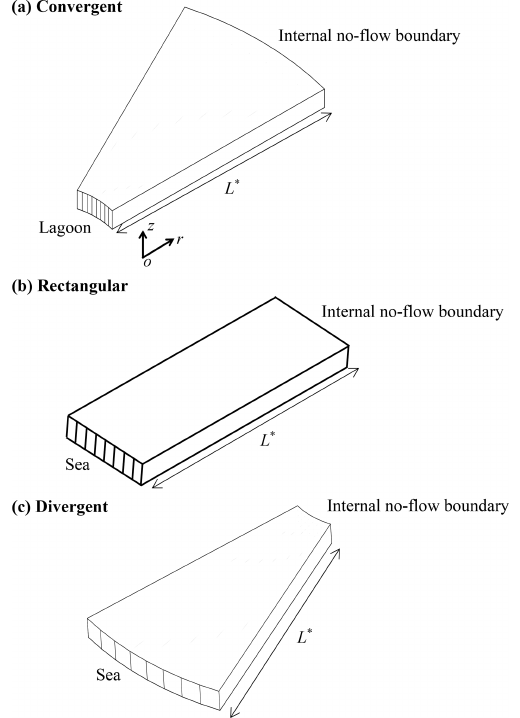
Figure 5. Three-dimensional view of (a) convergent (smaller side facing the lagoon), (b) rectangular and (c) divergent aquifers (larger side facing the sea) compared in this study. L ∗ represents the dis- tance from the sea/lagoon to the internal no-flow boundary, i.e., l 1 or l 2 in Fig. 2. The internal no-flow boundary corresponds to the z axis in Fig. 2.